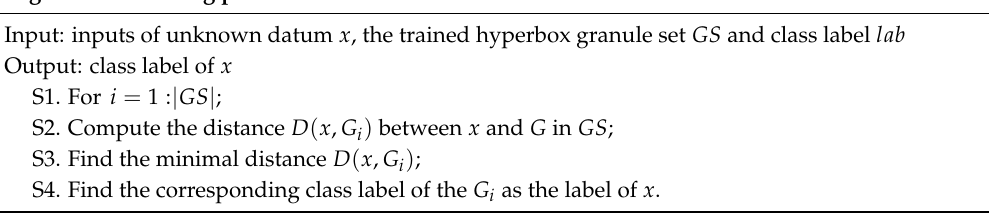
Algorithm 2: Testing